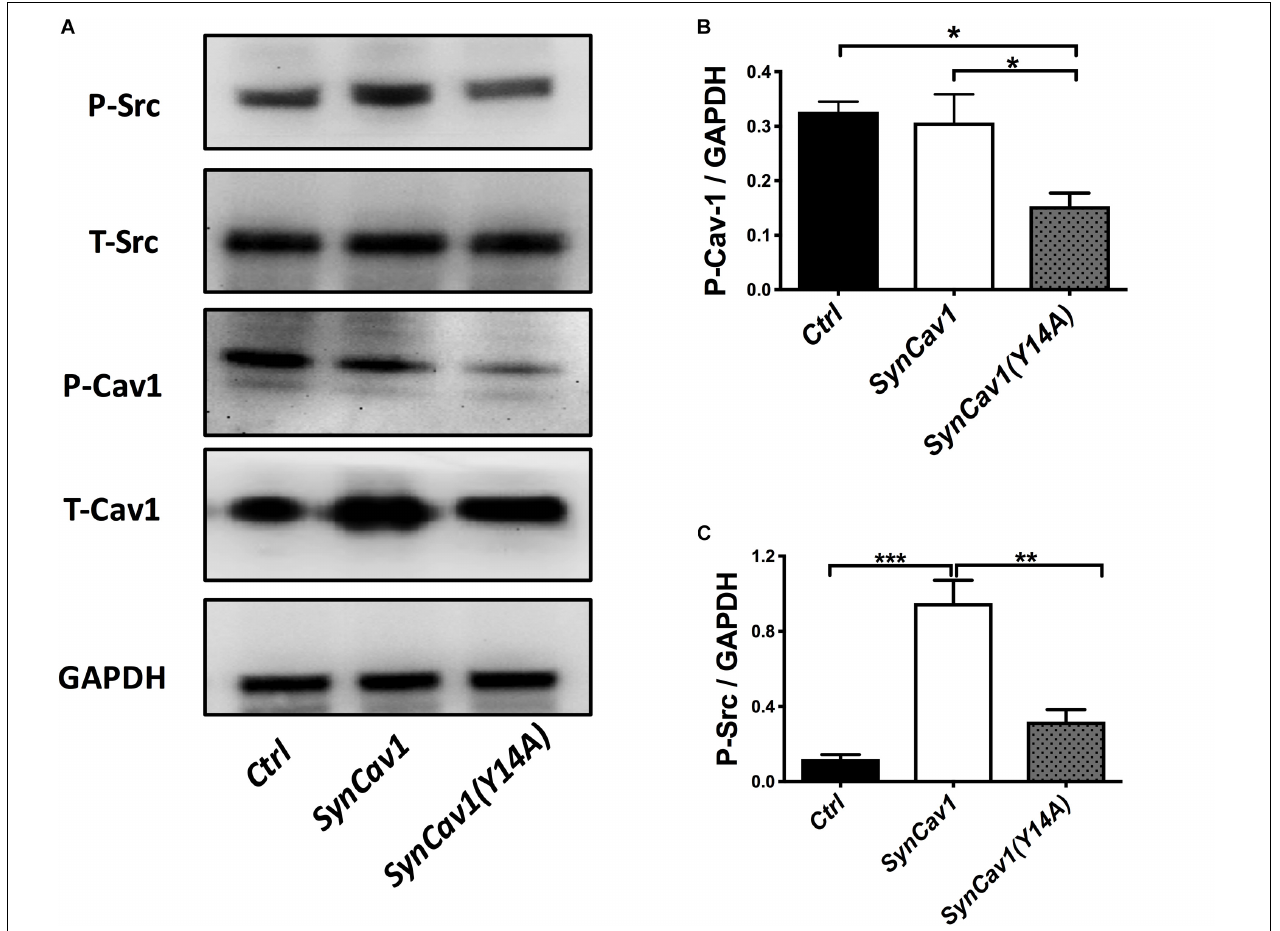
FIGURE 6 | SynCav1 (Y14A) inhibits P-Cav-1 expression in NPCs. NPCs were incubated with SynRFP, SynCav1, or SynCav1(Y14A) (2 × 10 9 IU/ µ l) on day 3. On week 2, NPCs were lysed and probed for P-Src(Y416), T-Src, P-Cav-1(Y14), T-Cav-1, and GAPDH. Quantitation for P-Src and P-Cav-1 are shown in (B , C) , respectively. Data are expressed as mean ± S.E ( n = 3, ∗ p < 0.05, ∗∗ p < 0.01, ∗∗∗ p < 0.001, One-way